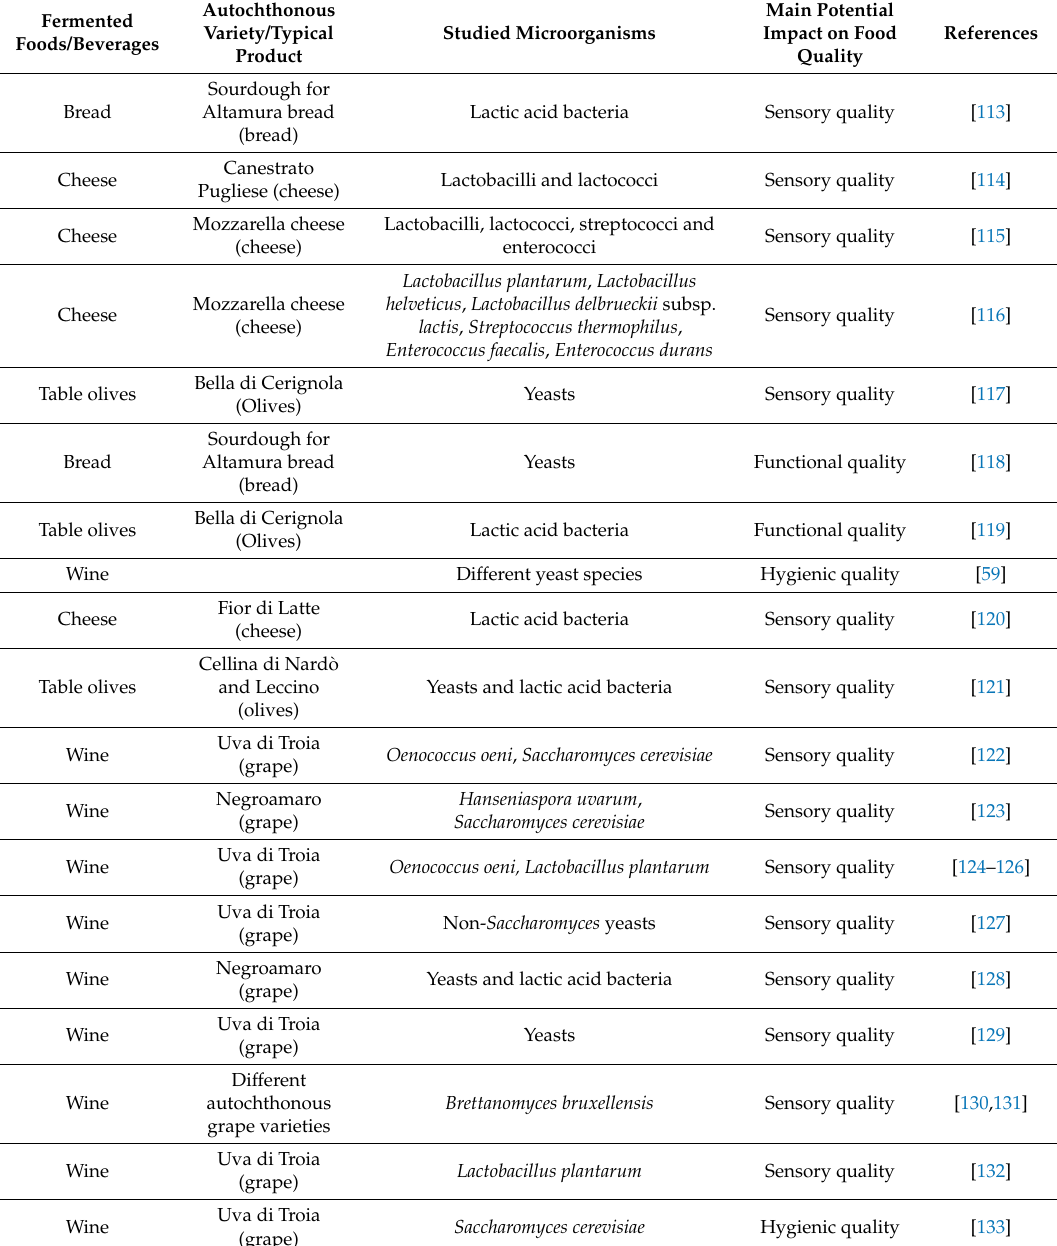
Table 8. Exemplificative cases of characterization of indigenous microorganisms selected from spontaneous fermentation in Apulian region (Southern Italy) in the last 15